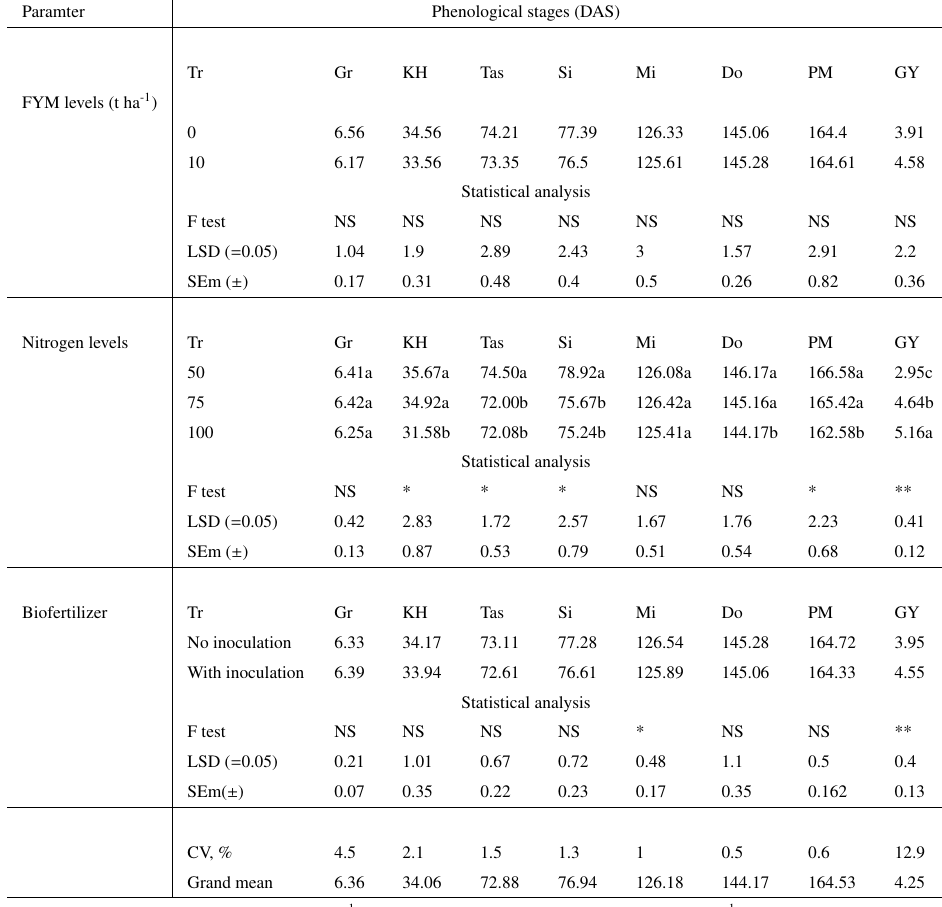
Table 2. Weekly maximum and minimum temperature, relative humidity, rainfall and solar radiation during research period at NMRP, Rampur, Chitwan, Nepal, 2015 / 16. Table shows Treatments (Tr), Germination (Gr), Knee high (KH), Tasseling (Tas),Silking(Si), Milking (Mi), Dough (Do), Physiological maturity (PM), and Grain Yield (t ha -1 ) (GY)